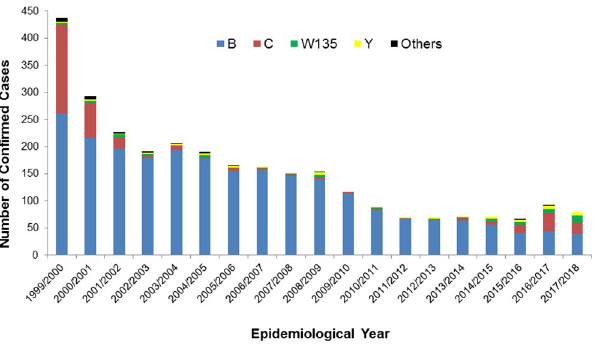
Fig 1. Confirmed incidence of IMD by serogroup in the Republic of Ireland, during the 1999/2000 to 2017/18 epidemiological years. A reduction in MenC IMD is observed in the years immediately preceding the meningococcal conjugate C vaccine introduction (October 2000). MenC disease incidence remains low for several years before increasing again during the most recent epidemiological years, and concomitant with increases in MenW disease